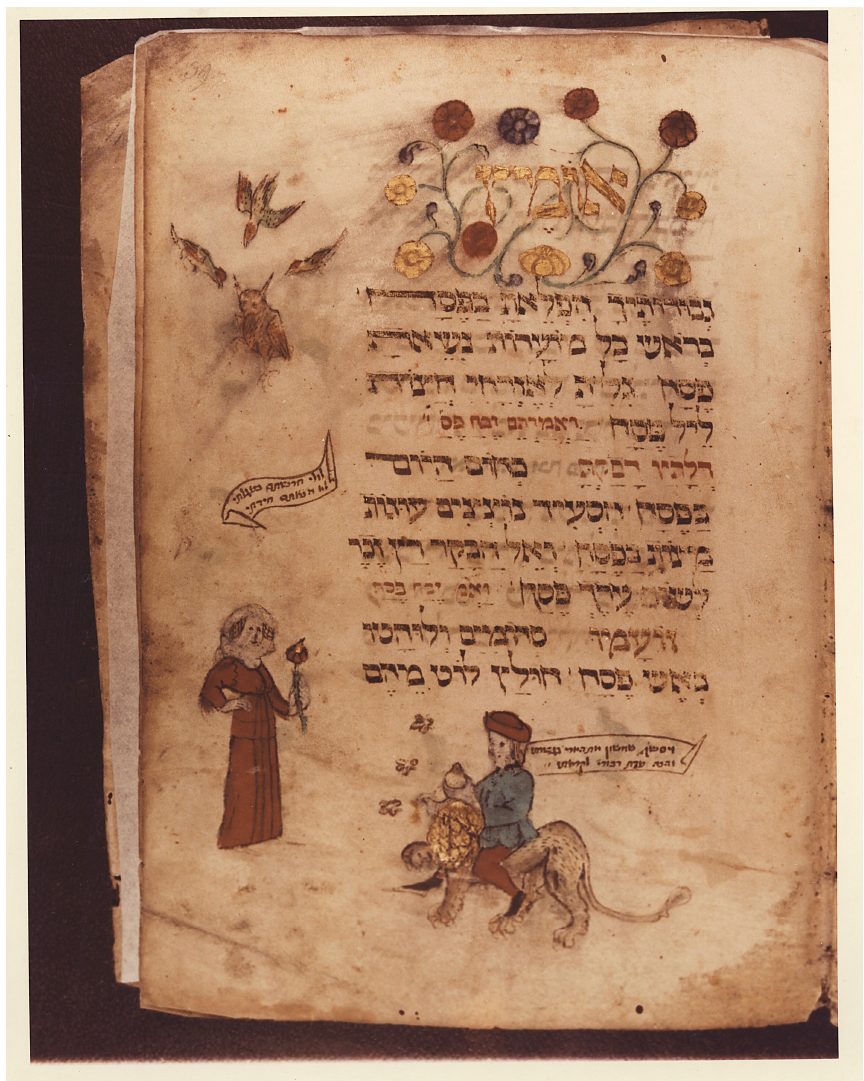
Figure 3. An owl attacked by birds. “Second Nürnberg Haggadah”, Germany, fifteenth century; COLLECTION OF DAVID SOFER LONDON, fol. 39r. Used by